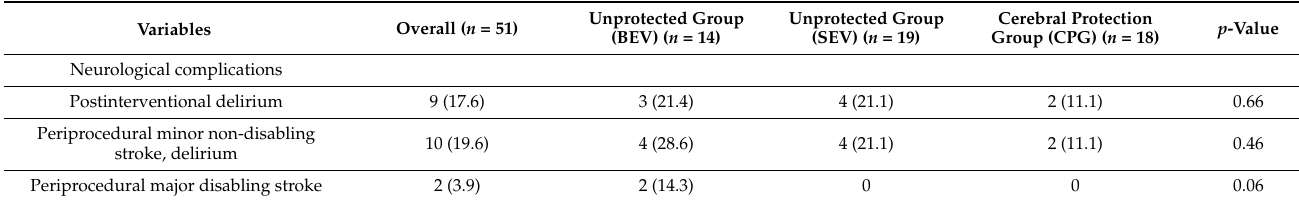
Table 4. Cerebrovascular